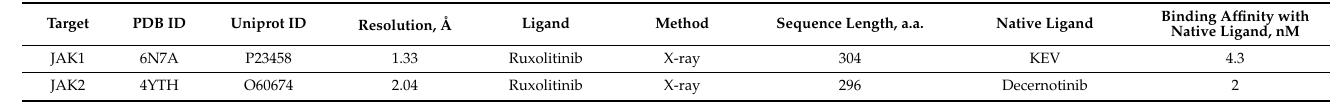
Table 4. Structures of JAK1 and JAK2 proteins used for redocking with